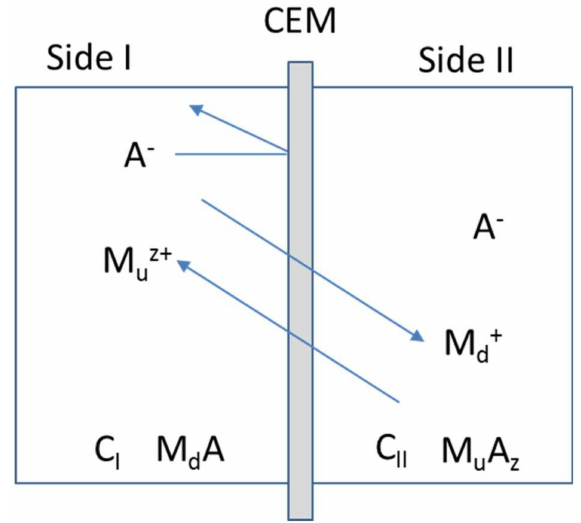
Figure 1. A schematic diagram of an example of Donnan dialylsis system with a cation-exchange membrane. In this case, side I and II chambers contain M d A as the driving electrolyte at an initial concentration of C I , and M u A z at an initial concentration of C II where the driving cations are the monovalnet ion, M d+ , and the uphill transported ions are M uz+ ions. The system has common anions as A - ions generally. In a DD system, C I is higher than C II